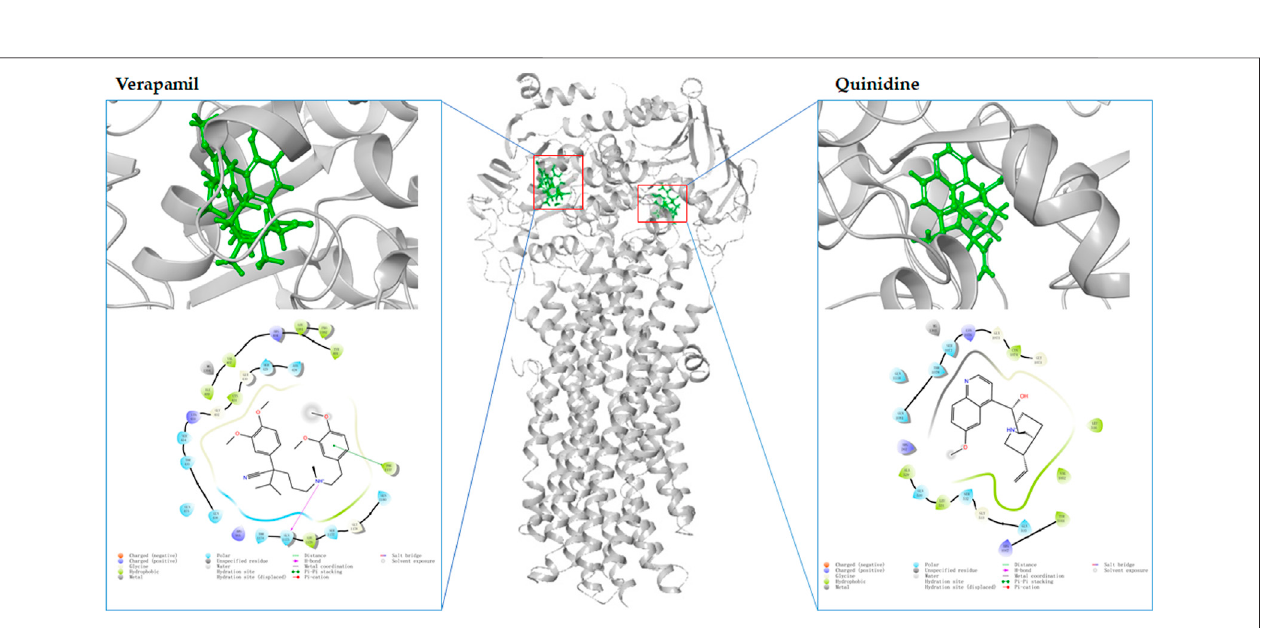
Frontiers in Pharmacology |